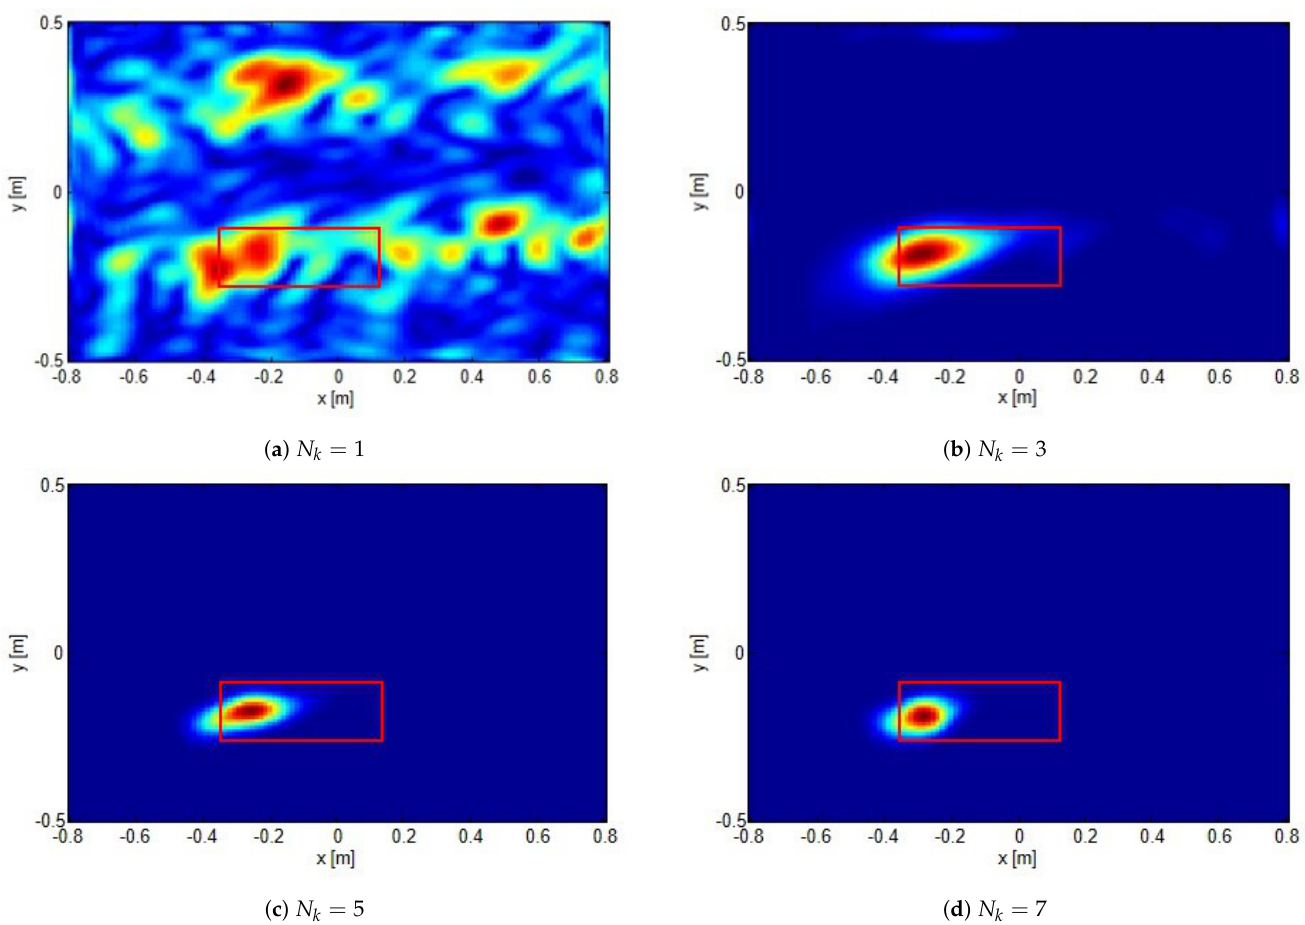
Figure 8. The same case as in Figure 7 with offsetx = 2.0 m; offsety = 0.3 m. Comparison of reconstructions obtained by employing different number of frequencies N k .